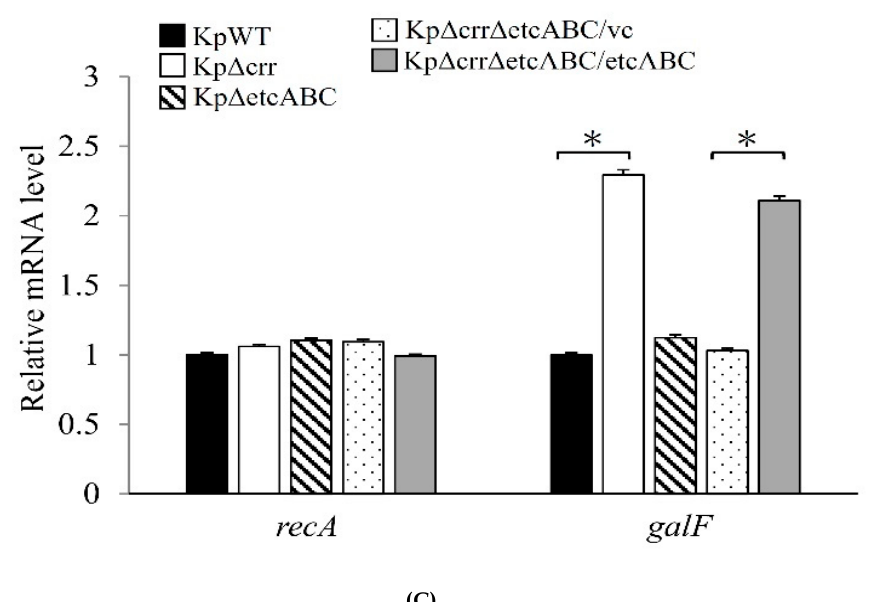
Figure 5. Overexpression of etcABC increased CPS production in K. pneumoniae . ( A ) Transcriptional analysis of etcA , etcB and etcC in the wild-type (slashed bar) and crr mutant (black bar) by probe-based RT-qPCR. The relative mRNA levels indicate that the mRNA amount in Kp ∆ crr was normalized to that in KpWT. ( B ) Quantification of CPS. KpWT: K. pneumoniae STU1 wild-type. Kp ∆ crr: K. pneumoniae crr mutant. Kp ∆ crr ∆ etcABC: both crr and etcABC were deleted in K. pneumoniae . Kp ∆ crr ∆ etcABC/etcABC: Kp ∆ crr ∆ etcABC carrying pBSK-Gm: Km::etcABC for overexpression of etcABC . ( C ) Transcriptional analysis of the housekeeping gene recA and cps locus gene, galF , by probe-based RT-qPCR. The relative mRNA levels indicate that the mRNA amount in each strain was normalized to that in KpWT. KpWT (black